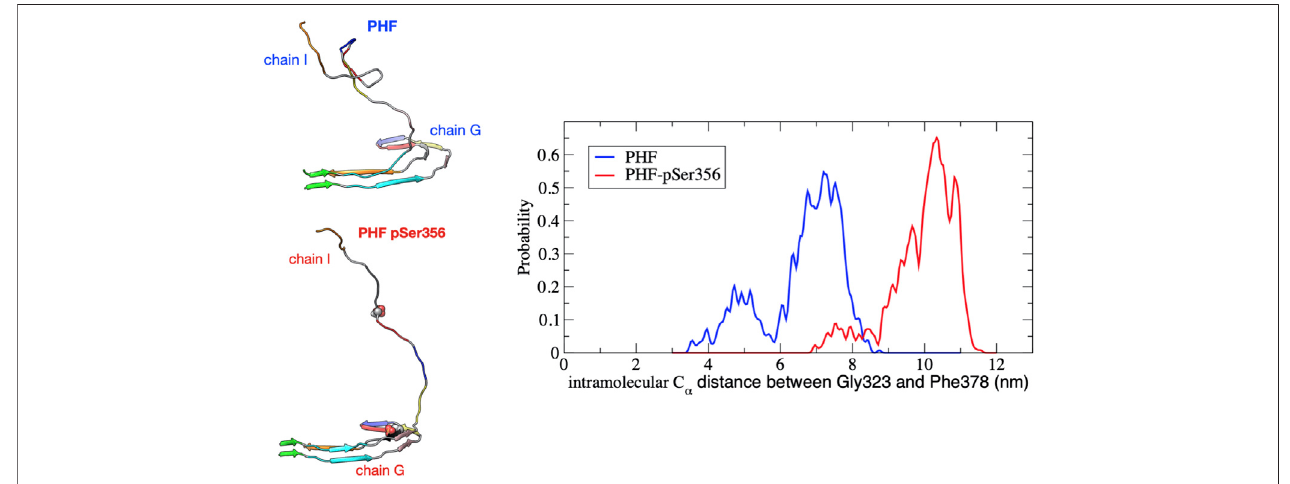
FIGURE4| DistributionoftheintramolecularC α distancebetweenresiduesGly323andPhe378onchainIforthePHF(blue)andPHF-pSer356(red)proto fi brilover the umbrella window restrained at a COM distance of 3.6 nm. The distribution is accumulated over the 10 ns production simulation. At this separation distance, the partiallyfoldedtauremainsincontactwiththeproto fi brilatthe β 1end(V306).Asnapshottakenat5 nsduringthe10 nstrajectoryisshownforbothstructures.ThePHF- pSer356 remains predominantly in an extended conformation while the wild-type PHF adopts more compact con fi gurations forming non-native intramolecular